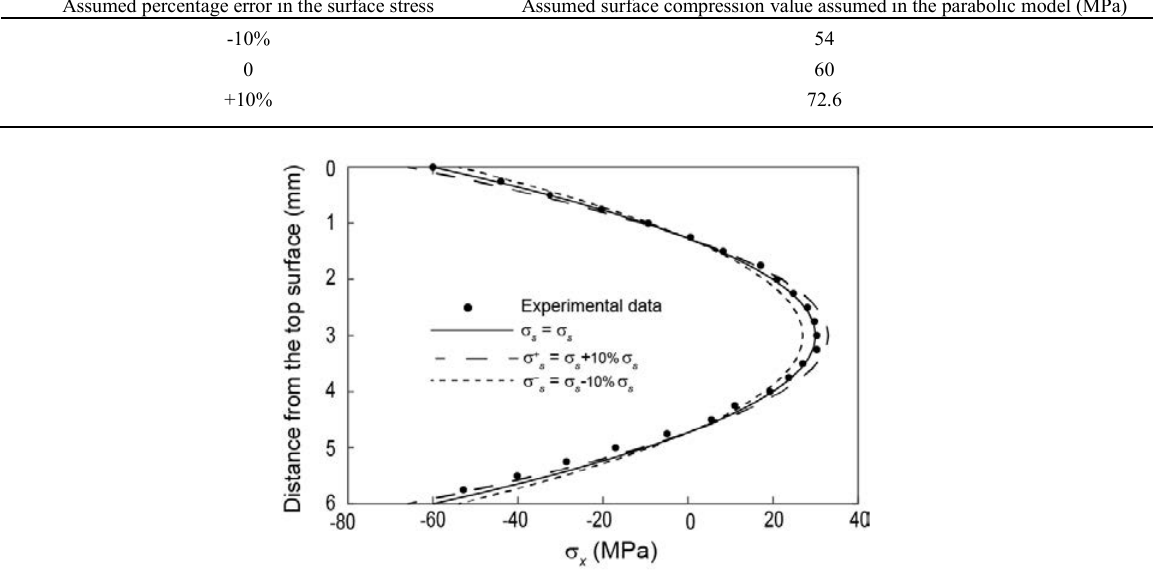
Fig. 5 Predicted residual stress depth profile based on different assumed surface stress values and the measured residual stress data for 6 mm thick heat-strengthened glass test